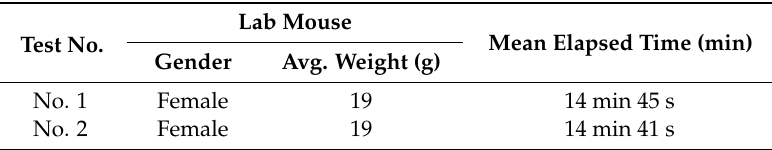
Table 3. Gas toxicity test result.